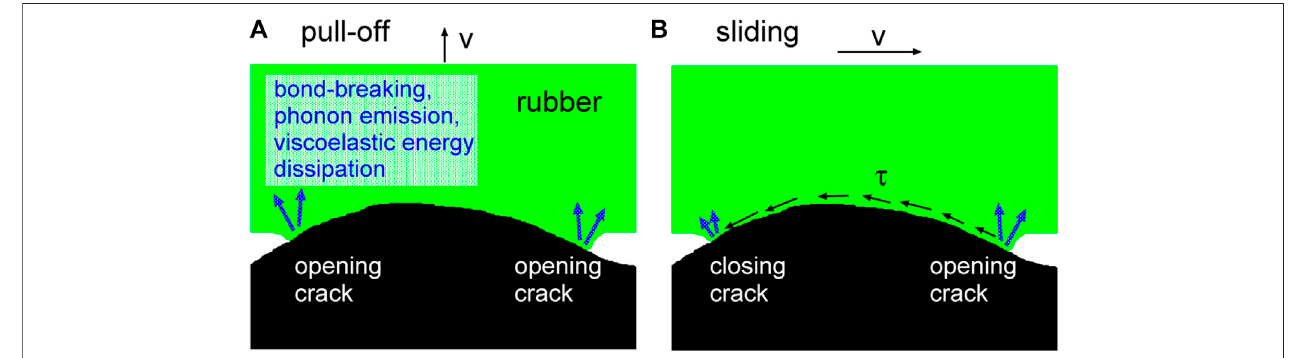
FIGURE 15 | There is in general no simple relation between adhesion (pull-off force) and sliding friction (A) The pull-off force depends on breaking the bonds in the normal direction at the edges of the contact region (opening crack propagation) (B) The friction force depends on energy dissipation at the opening and closing crack tips, and inaddition onshearingtheareaofrealcontact, i.e., onprocesses occurringeverywherewithinthecontact region. Inmany cases thislatter contribution willgive the most important contribution to the friction force (Tiwari et al.,